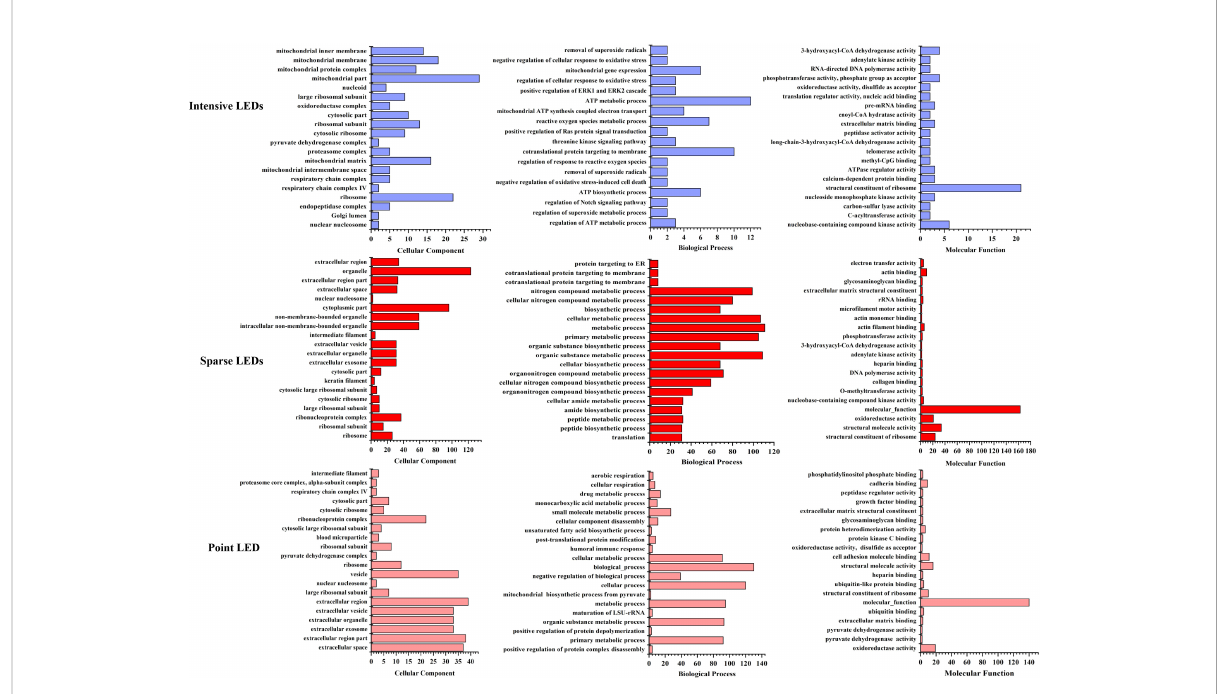
FIGURE 6 Assessment of the 20 most signi fi cant DEPs with the smallest p-value after intensive LED-PDT (top), sparse LED-PDT (middle), and point LED- PDT (bottom) using Gene Ontology (GO). DEPs were analyzed according to cellular component (left), biological process (middle), and molecular function